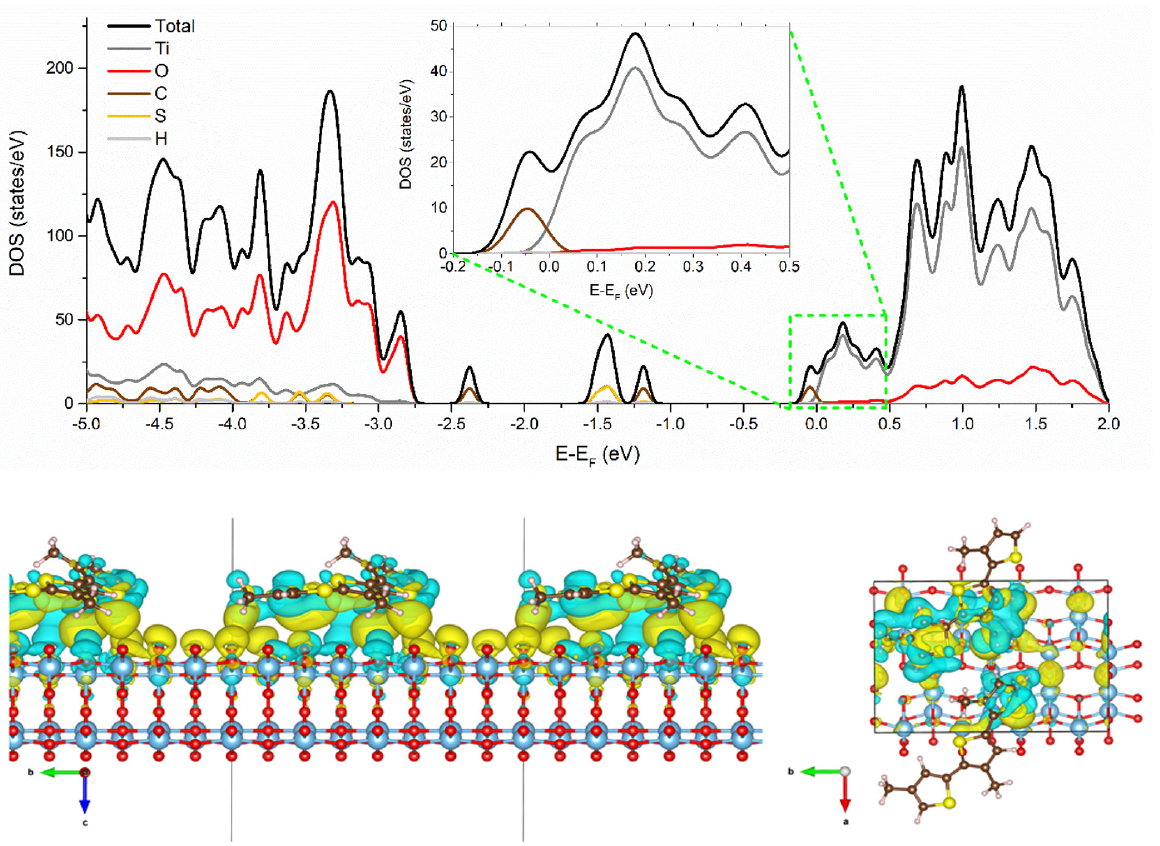
Figure 5. Total and projected density of states (DOS) ( upper panel) and charge density differences ( lower panel) for TiO 2 /3M system, where the loss and gain of electron density are represented in blue and yellow, respectively. References for atoms (colors) are carbon (brown), sulfur (yellow), hydrogen (light grey), oxygen (red) and titanium (dark grey).